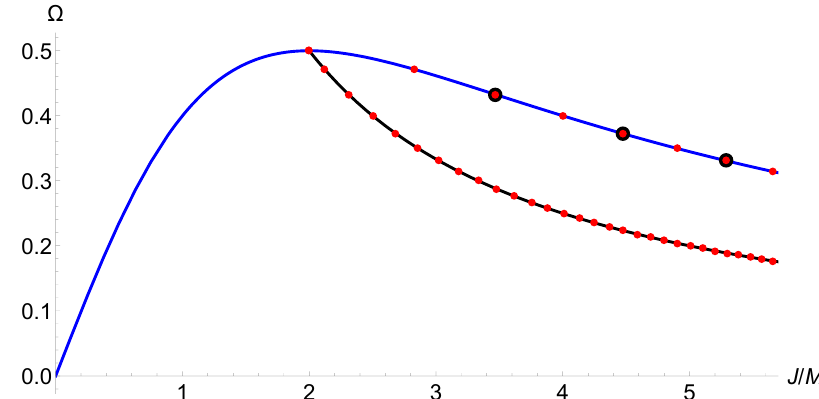
Figure 4 . Phases of Myers-Perry black holes (blue line) and black bars (black line) in the plane ( J=M; (cid:10)). The red dots indicate the presence of non-axisymmetric corotating zero modes for MP black holes (7.13) and for black bars (8.10). The ones in the MP branch encircled by a black dot indicate also axisymmetric zero modes (7.12). New families of solutions are expected to branch o(cid:11) all these